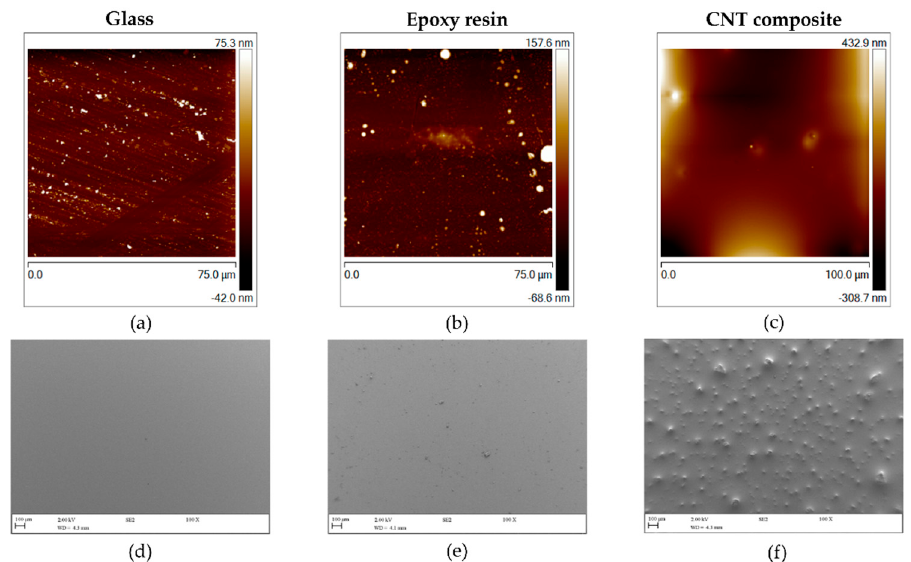
Figure 2. Two-dimensional AFM ( a – c ) and SEM ( d – f ) images of glass, epoxy resin, and CNT composite. The vertical color bars in the AFM images correspond to the z -range (surface height range) of the respective image. The SEM images have a magnification of 100× and the scale bar is equivalent to 100 μ m.